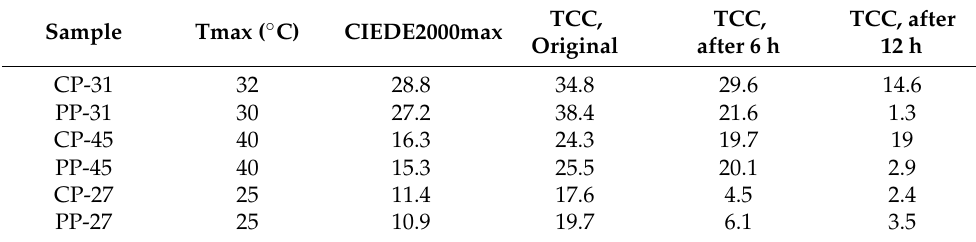
Figure 10. The total colour difference between the heated and cooled sample as measured for the TC27 (pink), TC31 (blue) and TC45 (red) samples (open signs represent PP printing substrate and solid CP printing substrate) before UV treatment, as a function of temperature. Table 5. Tmax and CIEDE2000max describe the temperature dependence of the total colour difference between the heated and cooled sample and TCC total colour contrast between the sample at the lowest and the highest measured temperature at an original sample and after 6 and 12 h of UV radiation